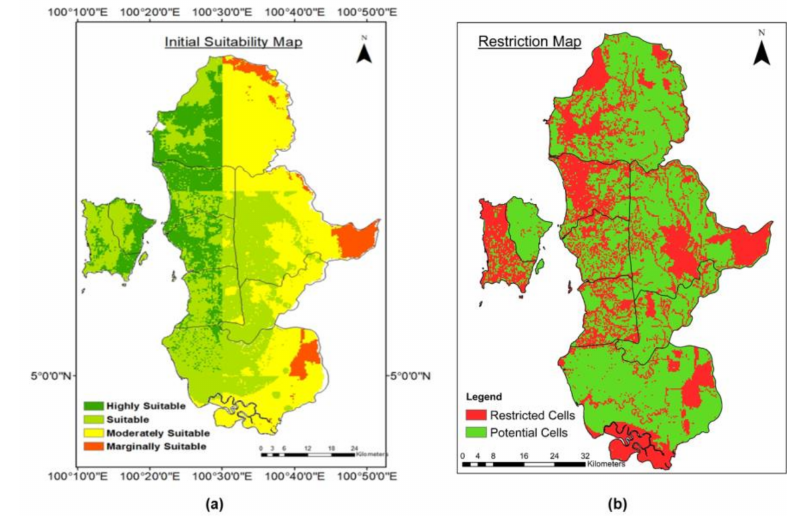
Figure 5. ( a ) The initial suitability map, ( b ) the restriction map.